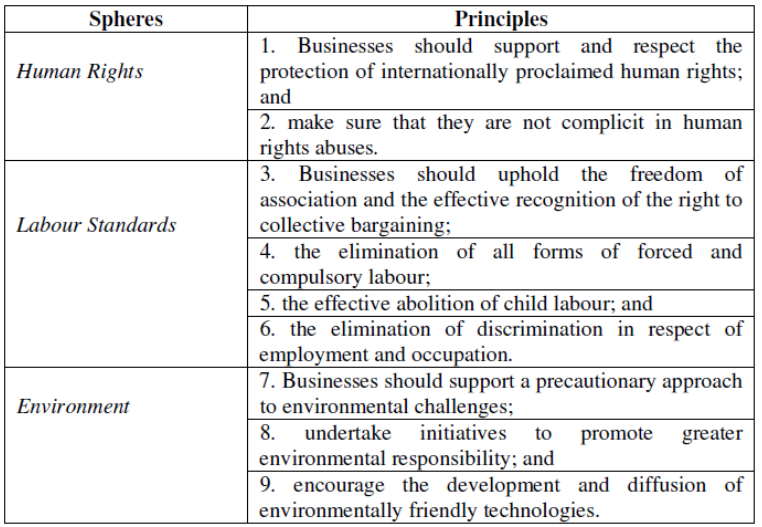
Figure 2: The Nine Principles of the Global